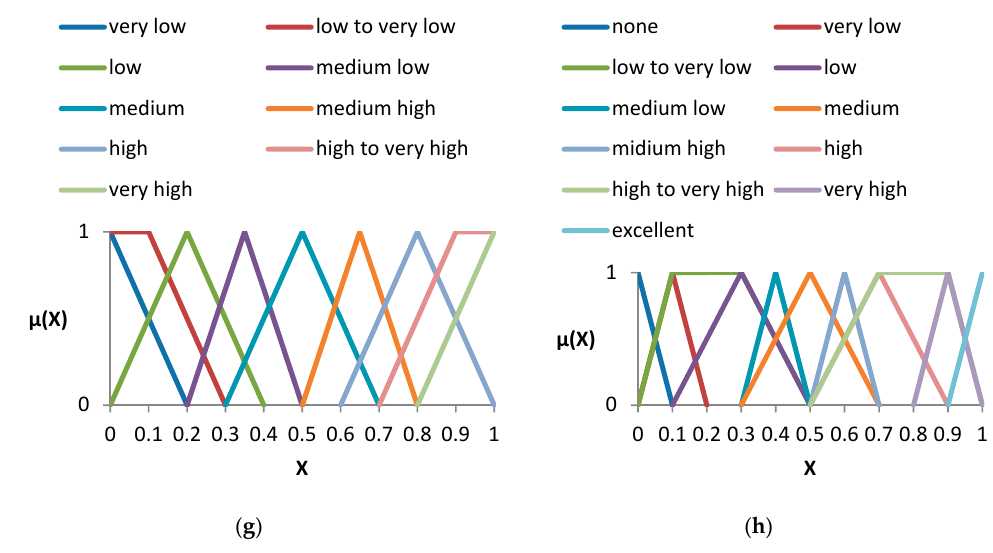
Figure 1. Scale ( a – h ) for the graph of membership function [22].